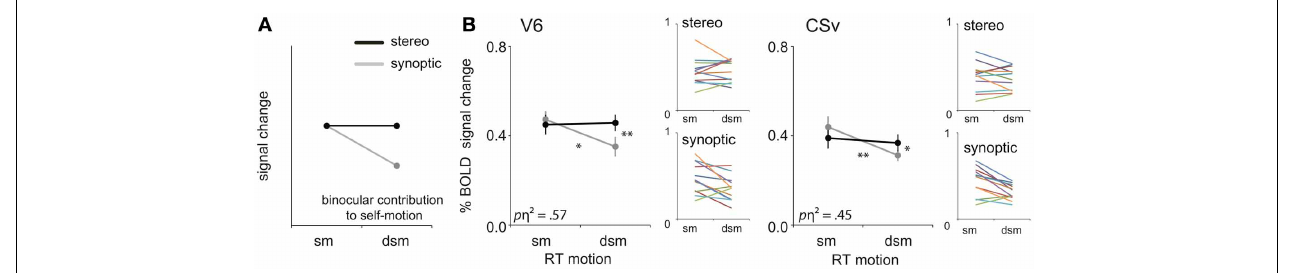
FIGURE 5 | Binocular processing of self-motion. (A) Prediction of the response pattern for a ROI that is involved in binocular processing of self-motion. When the retinal flow simulates complex self-motion (forward motion in combination with large rotational motion), degradation of that pattern’s structure by noise reduces the self-motion percept (synoptic condition), unless stereo information